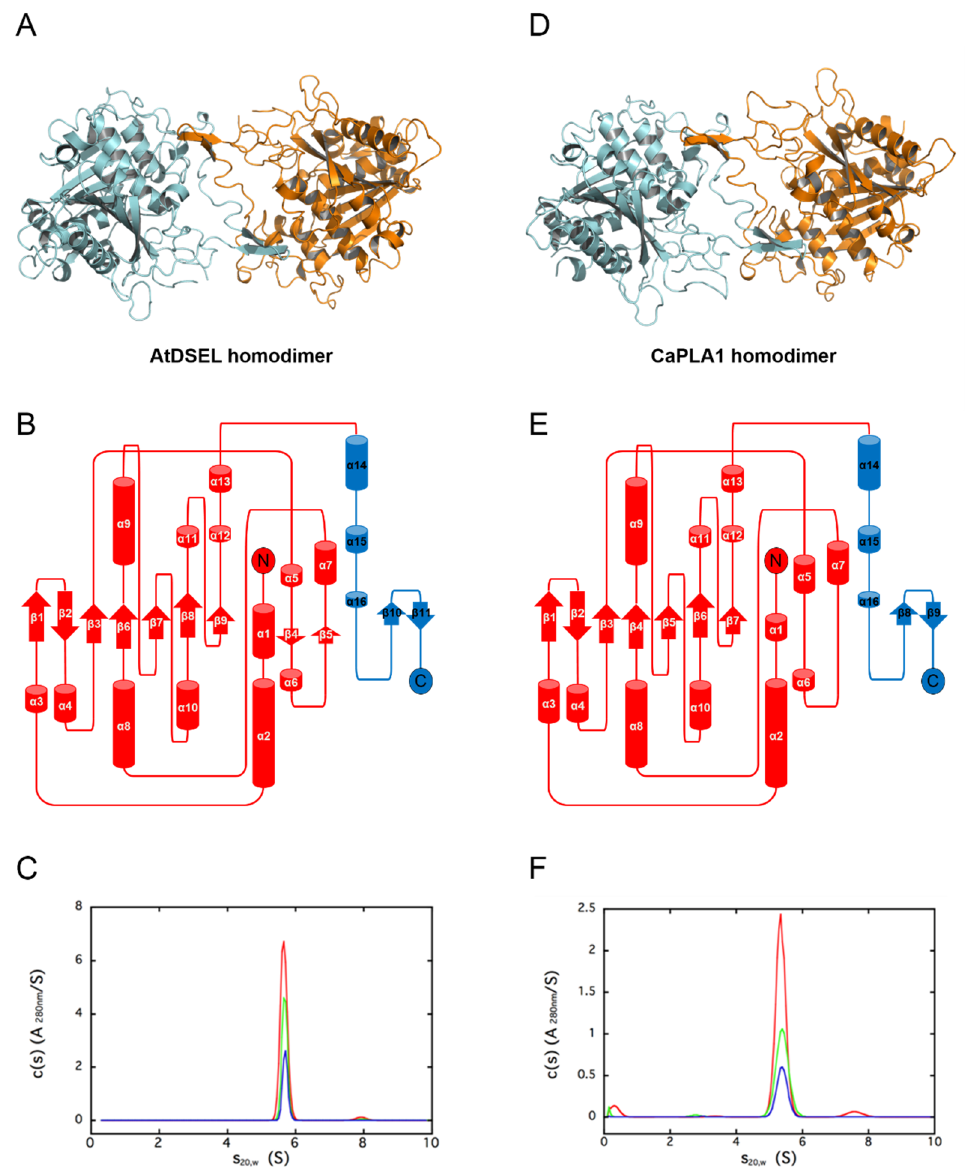
Figure 1. Overall structures of AtDSEL and CaPLA1. ( A ) Crystal structure of full-length AtDSEL. AtDSEL homodimer is shown as a ribbon diagram. Each monomer is colored in cyan and orange, respectively. ( B ) Topology diagram of AtDSEL monomer. α / β hydrolase domain and C-terminal domain are colored in red and blue, respectively. ( C ) Analytical ultracentrifugation (AUC) result of AtDSEL. The experiments were performed at following three protein concentrations: 3.0 mg/mL (colored in red), 1.5 mg/mL (green), and 0.8 mg/mL (blue). Calculated molecular weight of AtDSEL from the AUC peak is 95.3 ± 0.3 kDa, which strongly suggests that AtDSEL forms homodimers in solution, considering that the theoretical molecular weight of dimeric AtDSEL is 95.7 kDa. ( D ) Crystal structure of full-length CaPLA1. CaPLA1 homodimer is shown as a ribbon diagram. ( E ) Topology diagram of CaPLA1 monomer. ( F ) AUC result of CaPLA1. The experiments were performed at following three protein concentrations: 1.1 mg/mL (colored in red), 0.5 mg/mL (green), and 0.3 mg/mL (blue). Calculated molecular weight of CaPLA1 from the AUC peak is 86.0 ± 2.0 kDa, which strongly suggests that CaPLA1 forms homodimers in solution, considering that the theoretical molecular weight of dimeric CaPLA1 is 90.4